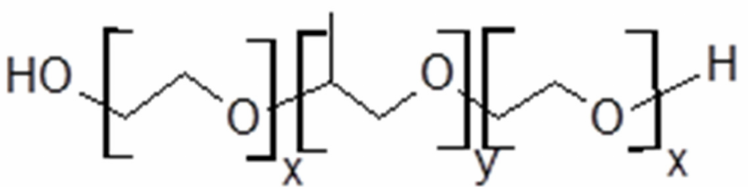
Figure 1. Generalised structure of a PEO-PPO-PEO triblock polymer (x and y represent the length of PEO and PPO blocks,